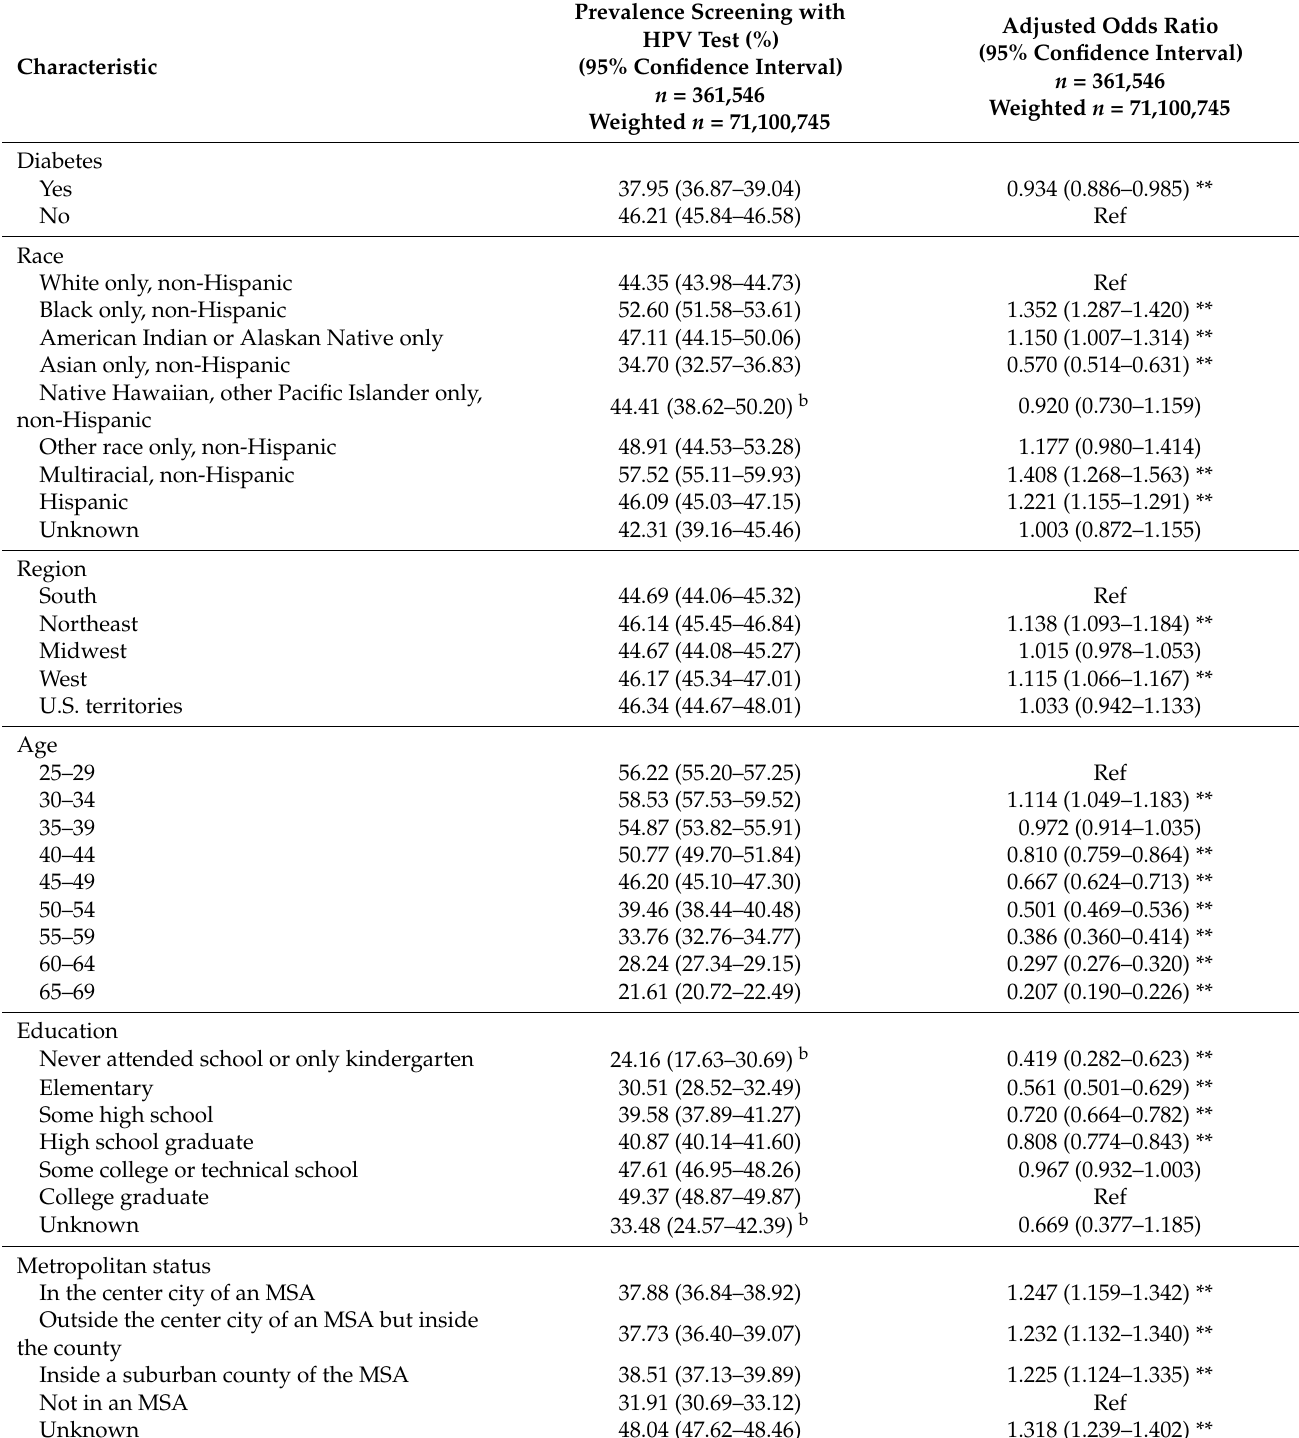
Table 2. Factors Associated with HPV Testing Behaviors among Female Study Population a